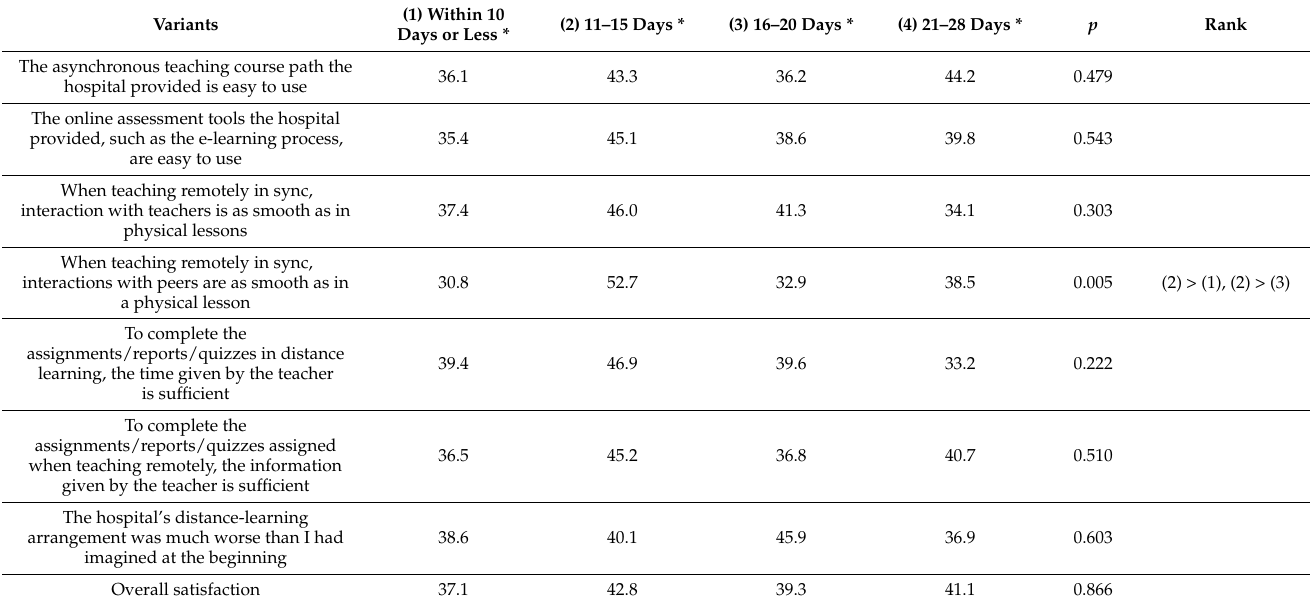
Table 5. Results of the Kruskal–Wallis test on the differences in satisfaction with distance-learning